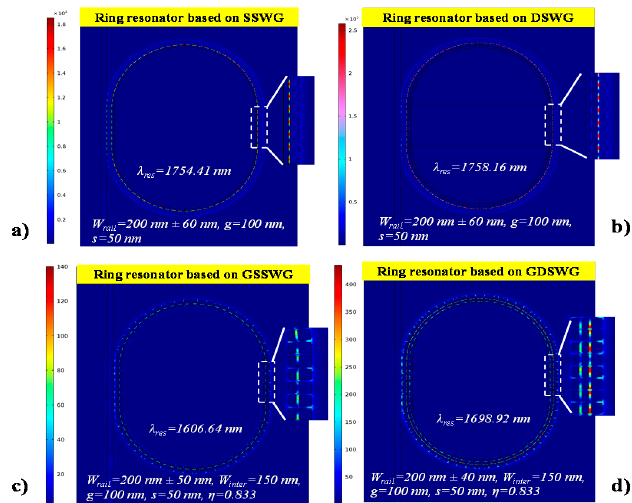
Figure 8. E-field distribution in ( a ) SSWG resonator, ( b ) DSWG resonator, ( c ) GSSWG resonator, ( d )GDSWG resonator. The inset shows the zoomed section of the ring resonator at λ res